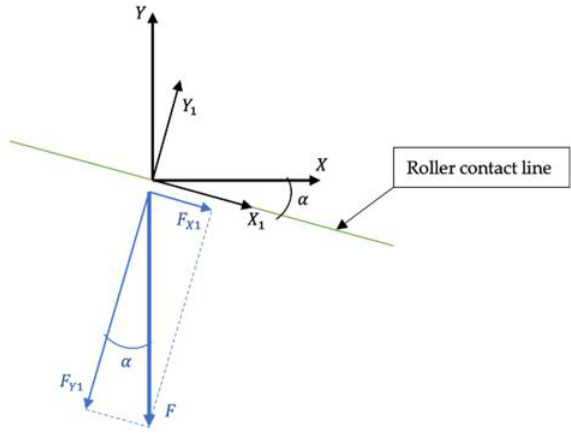
Figure 15. Decomposition of forces in the line of contact between roller and conveyor belt.